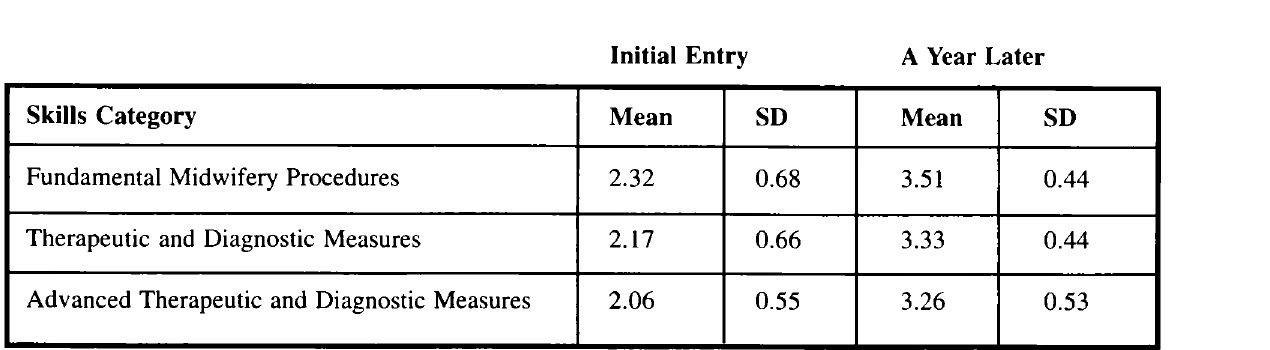
Table 1 : Means & Standard Deviation of Graduates’ Competencies in Midwifery